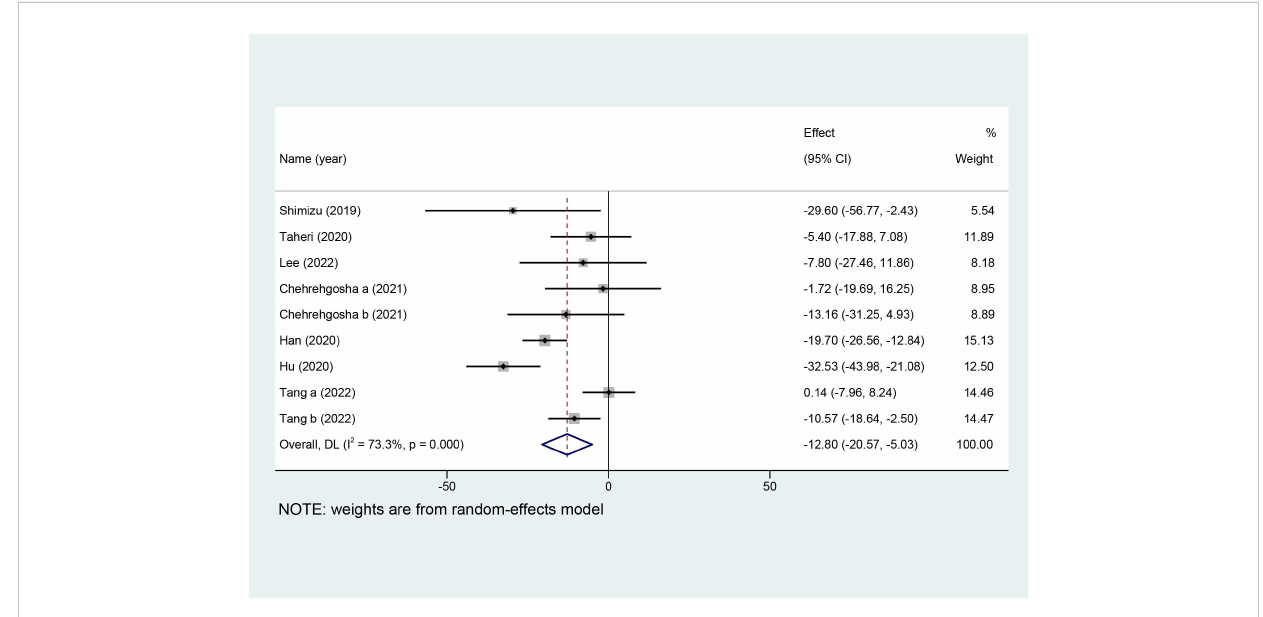
FIGURE 5 Forest plot of controlled attenuation parameter